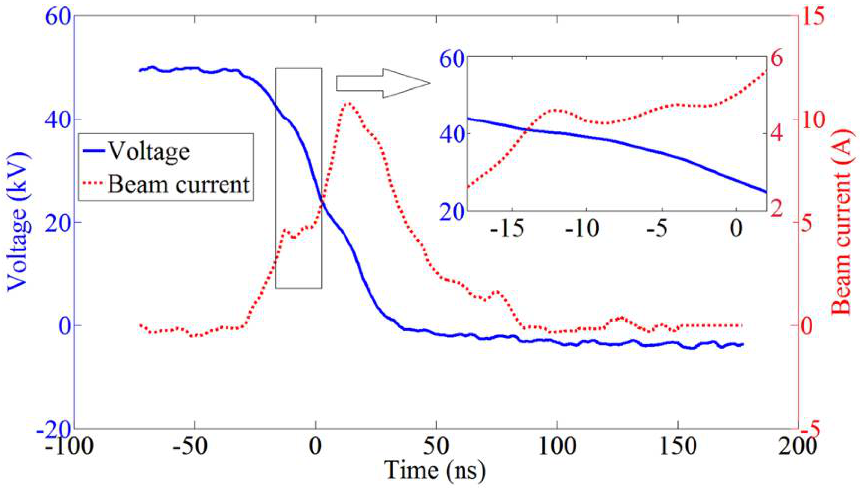
Figure 2. The voltage curve and current curve produced by PS discharge over time. Figure 3 is the structure of the designed EIO. An output waveguide and a resonant slow-wave structure make up the interaction circuit. The slow-wave structure includes nine gaps, a sheet beam tunnel, and two identical coupling cavities. The multi-gap slow-wave structure is intersected with a 0.7 mm × 0.25 mm rectangular electron beam tunnel. Two identical coupling cavities are symmetrically distributed above and below. The electromag- netic wave produced by the EIO in the resonant slow-wave structure is transmitted to the output structure. There is a coupling hole between the resonant slow-wave structure and the standard output waveguide. Table 1 is a list of the detailed device dimensions. The gap length of the EIO is ranged from 0.1 mm to 0.29 mm, searching for the shortest